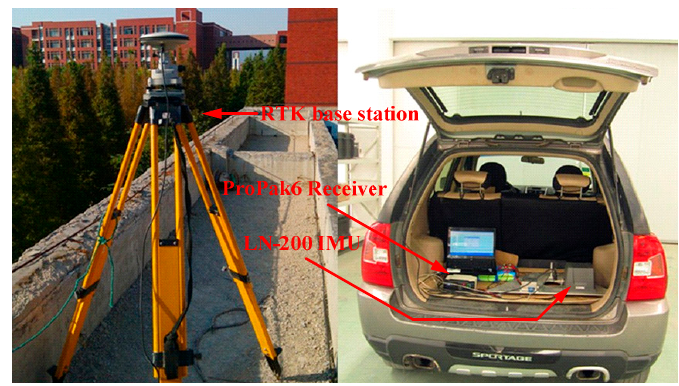
Figure 6. The field test setup.